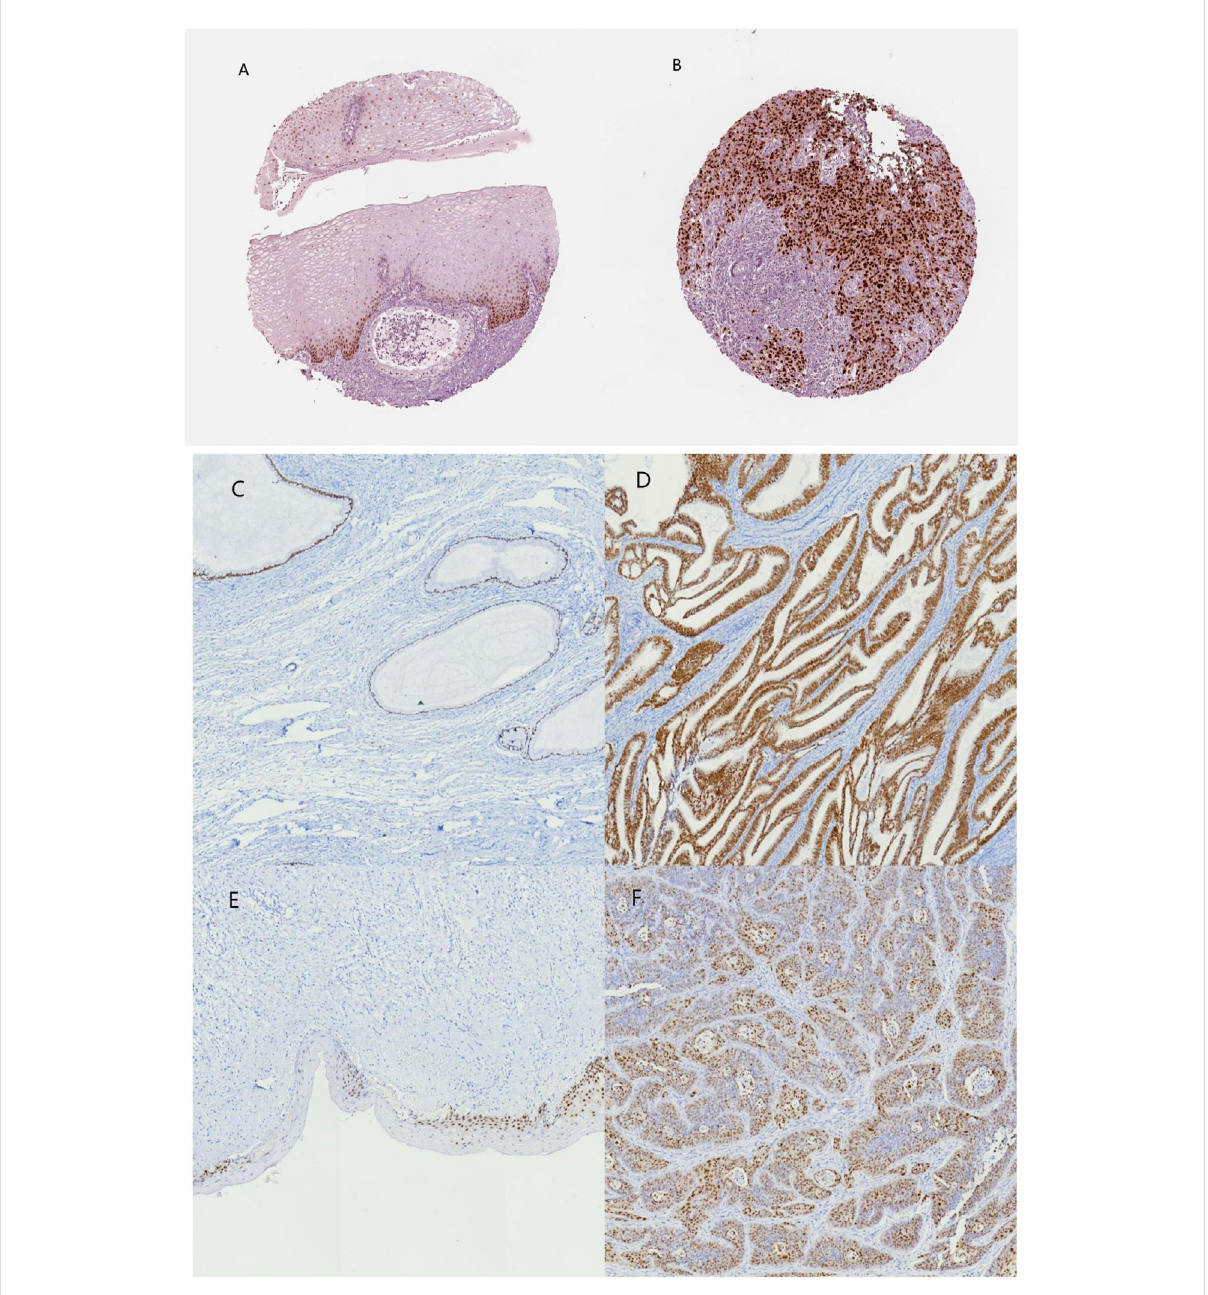
FIGURE 10 SOX9 immunohistochemical images of normal cervical and cervical cancer tissues on the HPA database and patient samples. (A) normal cervix (HPA), (B) cervical cancer (HPA), (C) normal cervical glands, (D) cervical adenocarcinoma, (E) normal cervical epithelium, and (F) cervical squamous